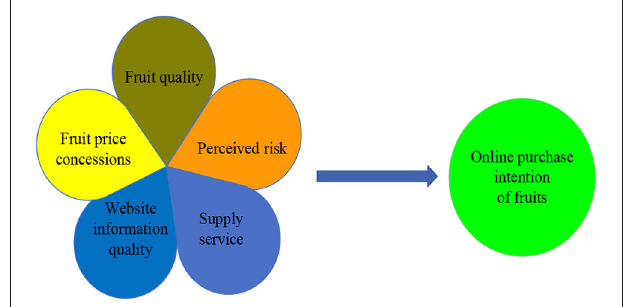
FIGURE 1 | Foundational research